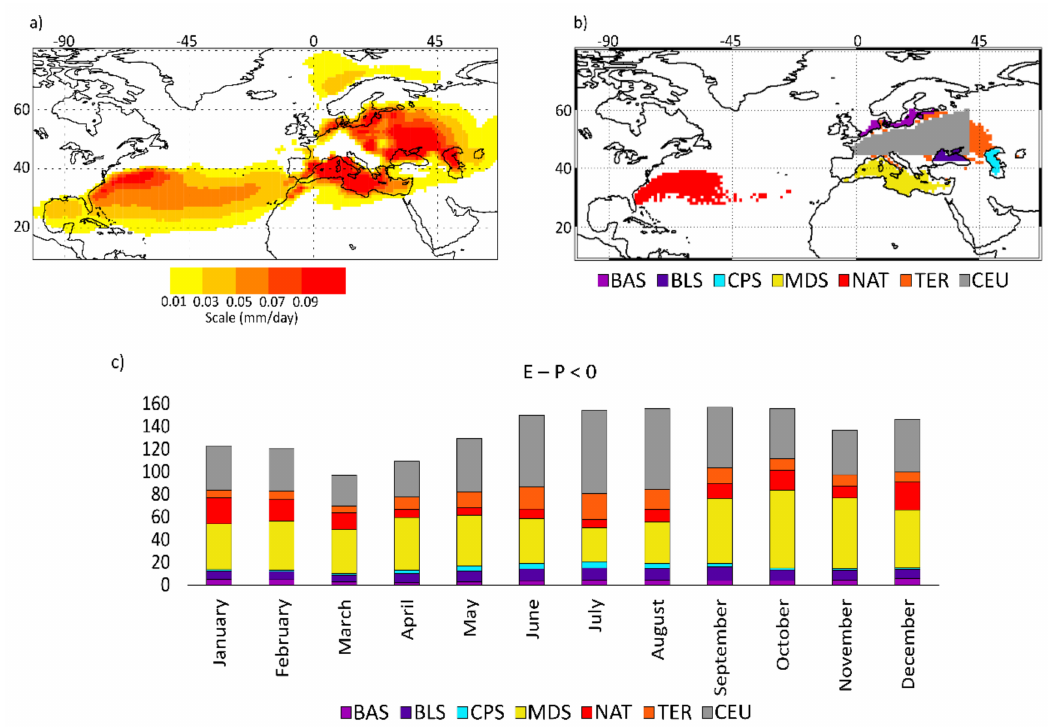
Figure 2. ( a ) Climatological annual (evaporation (E) − precipitation (P) > 0) values integrated backward in time over 10 days for the Central Europe region (CEU) (mm/day); ( b ) Schematic representation